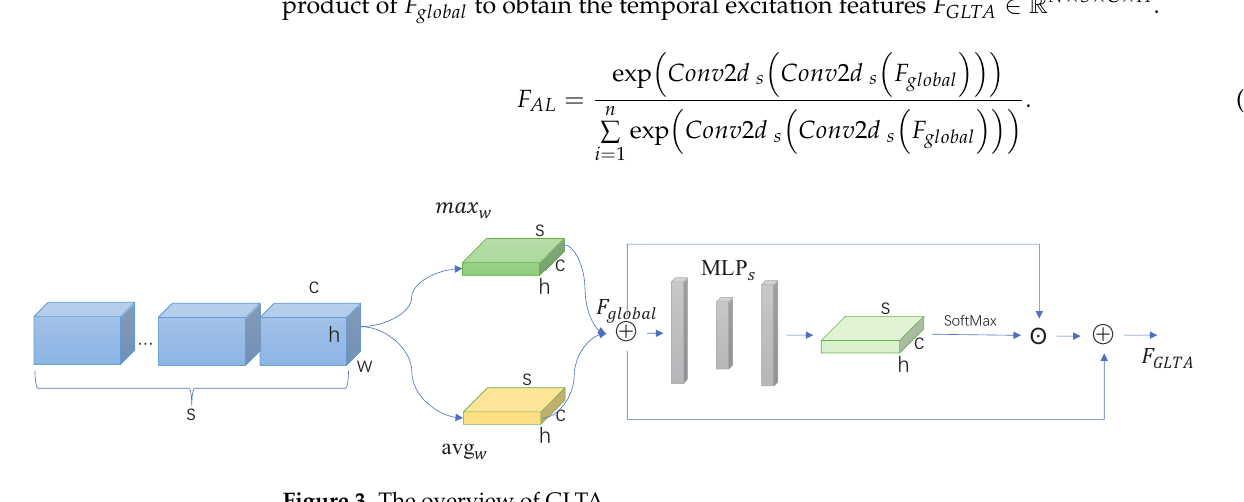
Figure 3. The overview of GLTA.